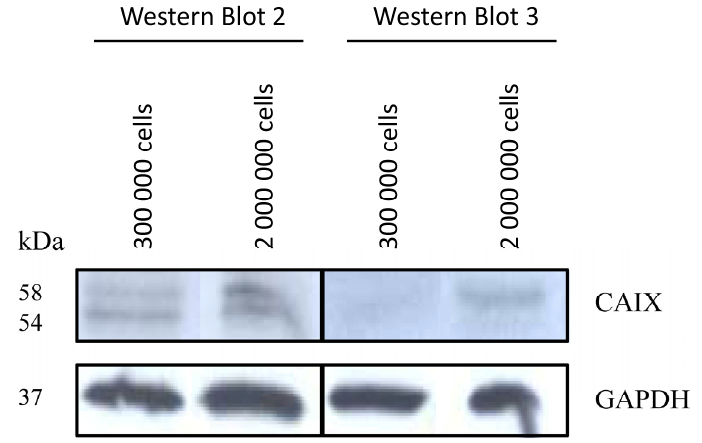
Figure 3. Western Blot analysis of different cultures of HCT116 cells treated under the same conditions of cellular density. GAPDH was used as loading